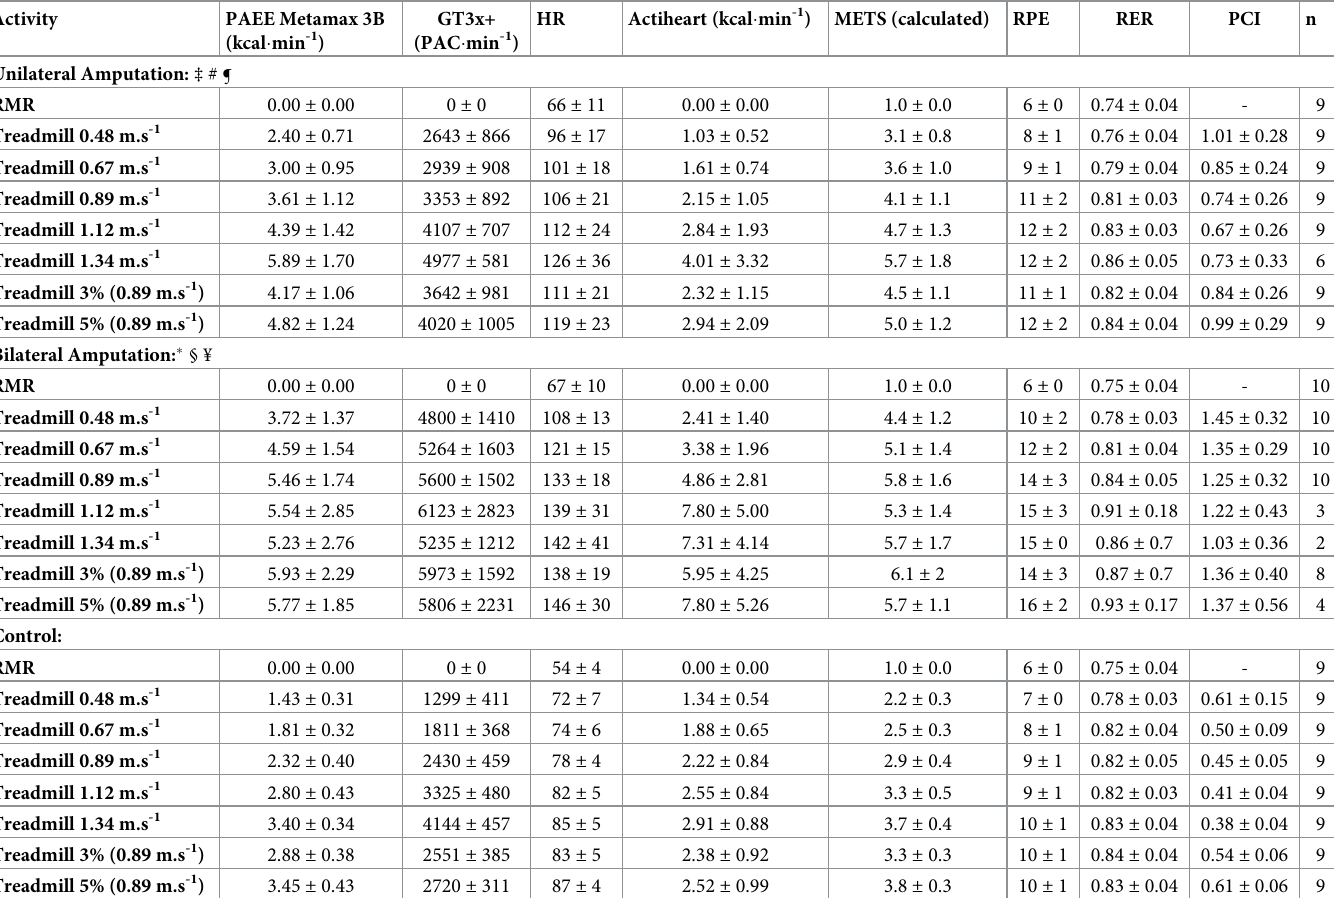
Table 2. Measured PAEE, accelerometer outputs at each anatomical location, calculated METs, RPE and number of participants for each activity (mean ±